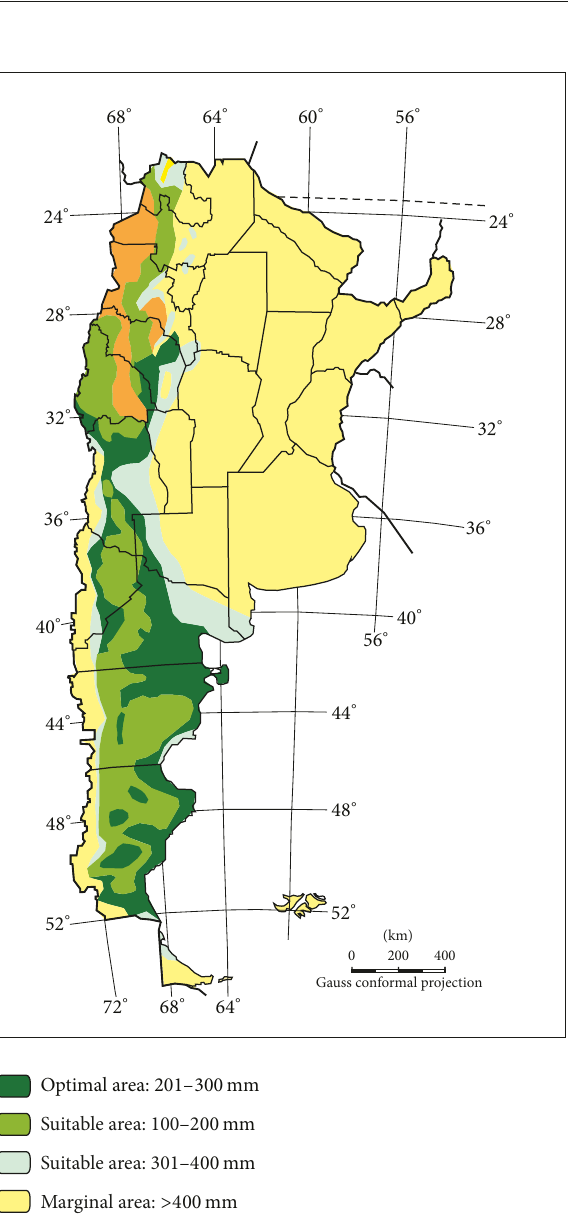
Figure 2: Annual